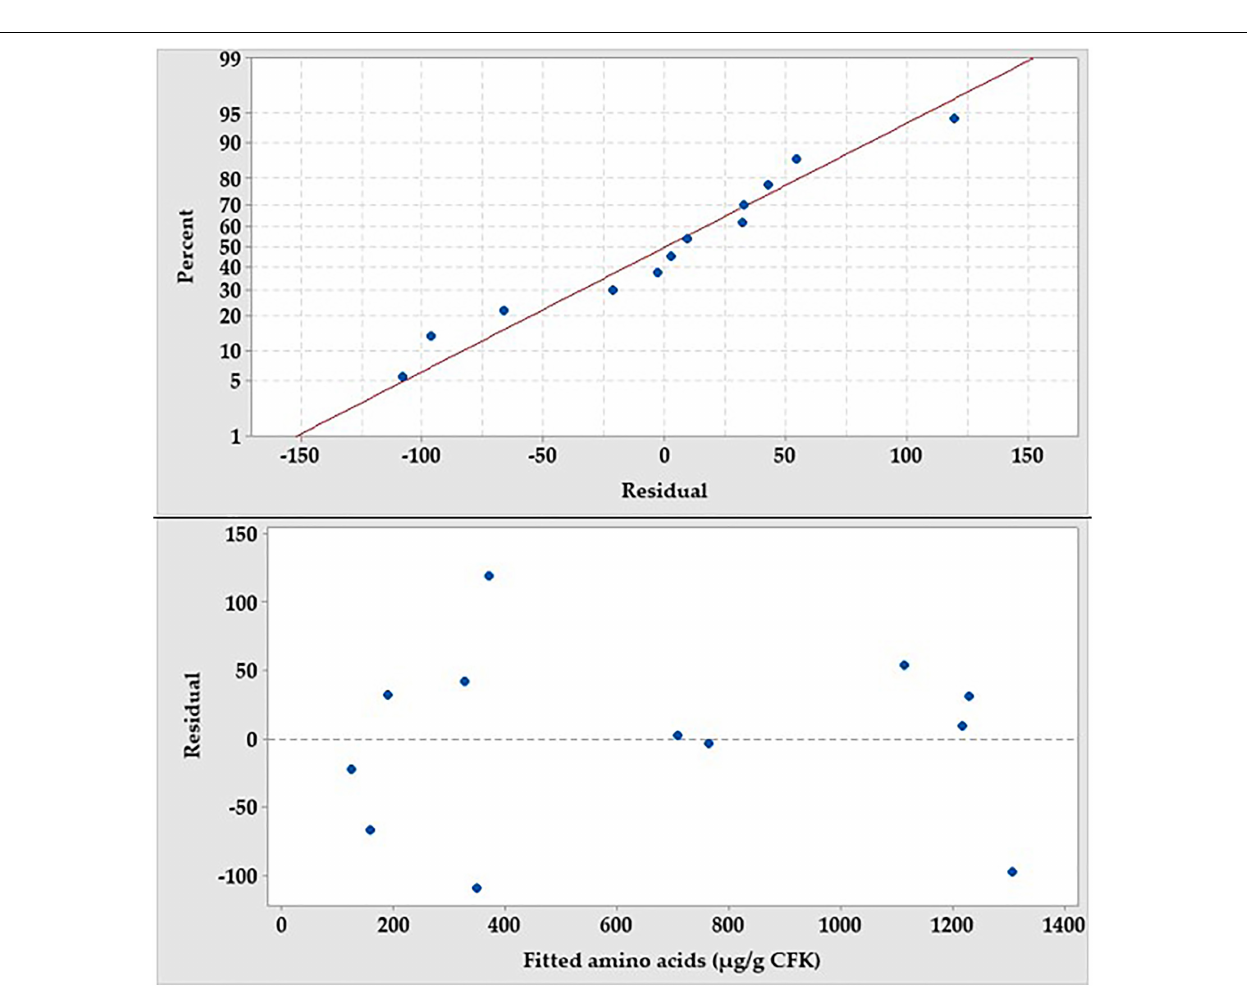
Frontiers in Microbiology |